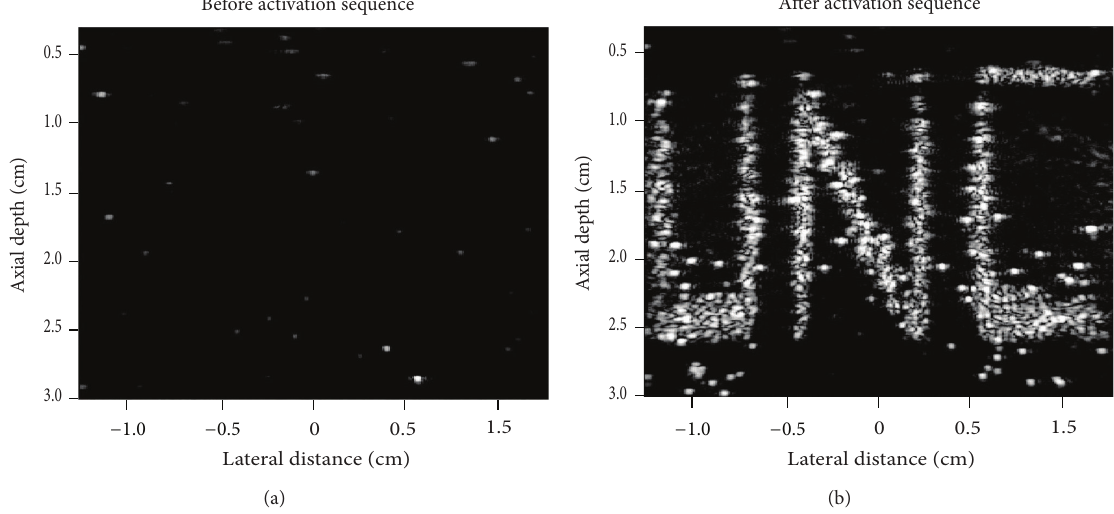
Figure 13: Plane-wave pulse inversion images of a room-temperature water bath containing OFP droplets before (a) the droplet activation sequence and immediately after (b) the final pulse of the activation sequence. The focus of each preprogrammed activation pulse was shifted using electronic steering to create the desired pattern in a left-to-right, bottom-to-top order. Unpublished data courtesy of Jordan